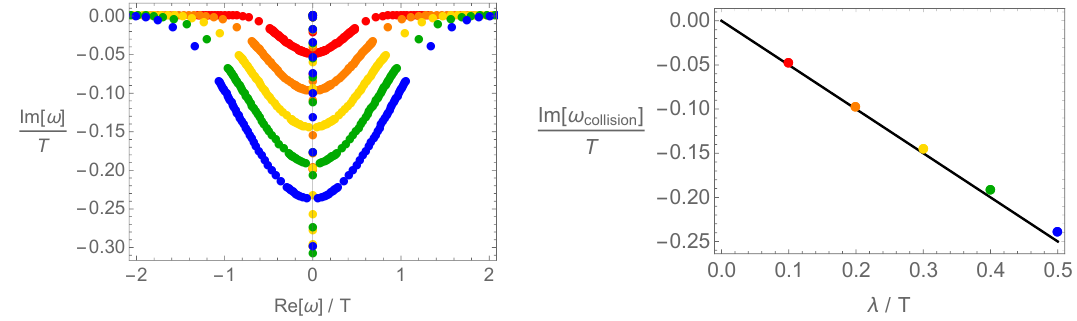
Figure 6 . Left: The dynamics of the lowest QNMs in the transverse spectrum at k = 0 for T/T c ∈ [1 , 0 . 3] with λ/T = 0 . 1 − 0 . 5 (from red to blue data). The red data corresponds to figure 5. Right: The collision frequency, ω collision , as a function of the EM coupling λ/T . The black solid line is the phenomenological finding in eq.